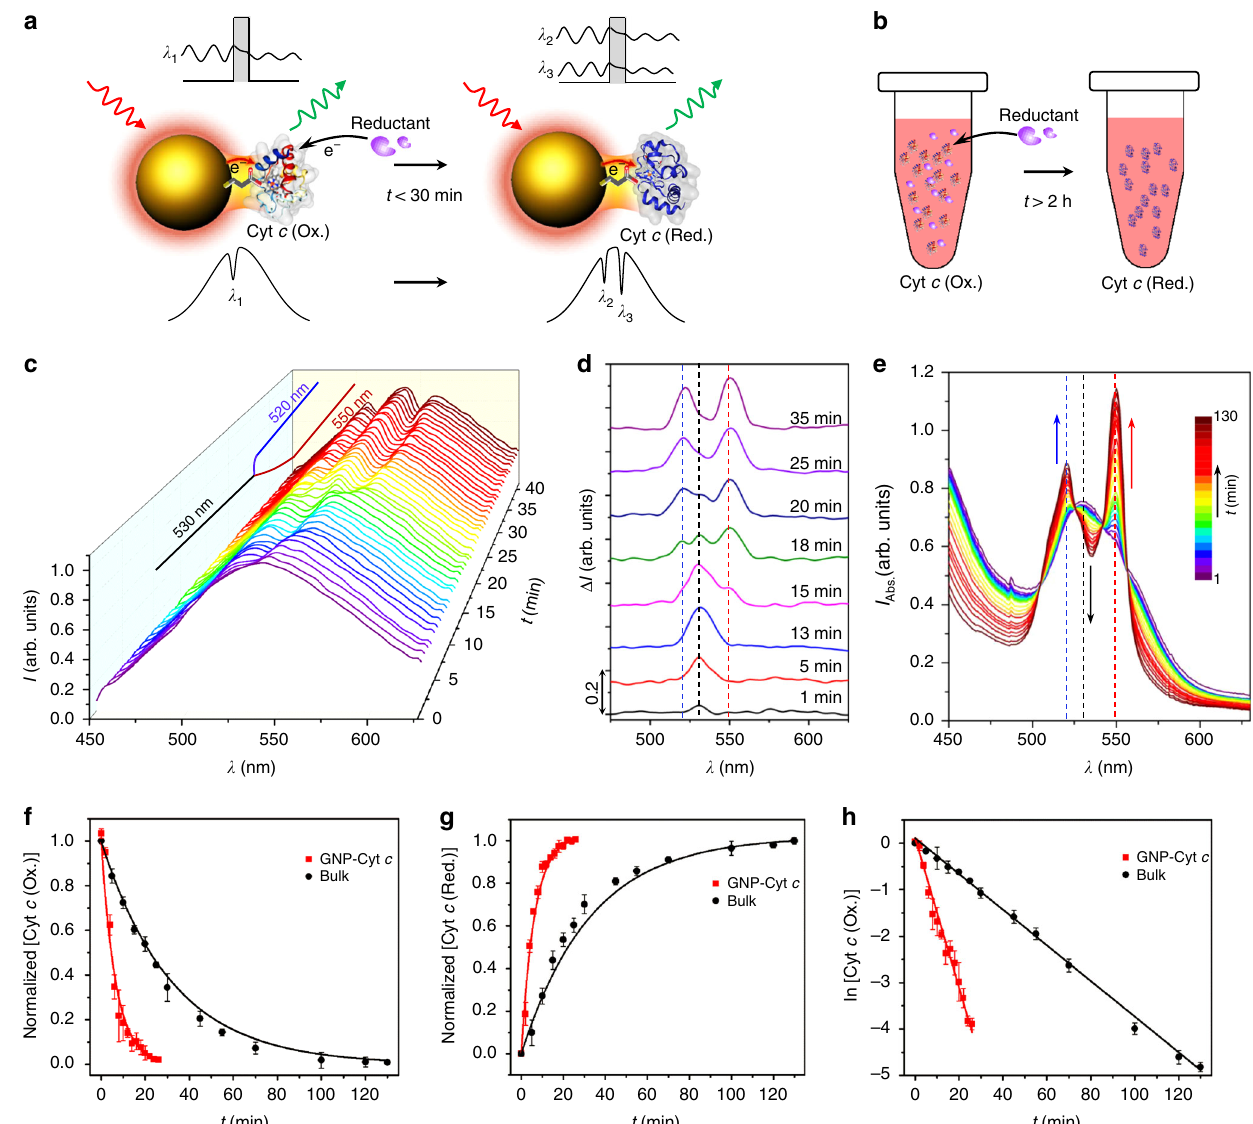
Fig. 3 Real-time QBET imaging during Cyt c reduction. a Schematic for QBET imaging during Cyt c reduction in A/B/C tunnel junction, with a total reaction time of less than 30 min. With reductant added, Cyt c (Ox.) is reduced to Cyt c (Red.), and the electron tunnelling through the barrier changes from λ 1 (530 nm) to λ 2 (520 nm) and λ 3 (550 nm). b Schematic for Cyt c reduction in bulk solution with a total reaction time of larger than 2 h. c Real-time scattering spectra of GNP-Cyt c conjugation in the whole Cyt c (Ox.) conjugating and reduction process, QBET in the reduction process is captured from the spectra dip changes which were splitted from 530 nm to 520 and 550 nm. d Representative scattering spectra difference (compared with the GNP without Cyt c at t = 0) in the reduction process showing the dip changes at different time. e Absorption spectra of Cyt c bulk solution during the reduction process. The absorption peak of 530 nm (dashed black line) for Cyt c (Ox.) is gradually decreased, while the peaks of 520 (dashed blue line) and 550 nm (dashed red line) for Cyt c (Red.) are gradually increased. f Normalised Cyt c (Ox.) concentration during the reduction process in both GNP-Cyt c conjunction and bulk solution. g Normalised Cyt c (Red.) concentration during the reduction process. h Plot of ln [Cyt c ] in the reduction process with linear fi t. The cartoons for Cyt c molecules in a and b were created from the RSCB protein data bank 54 . Error bars represent standard